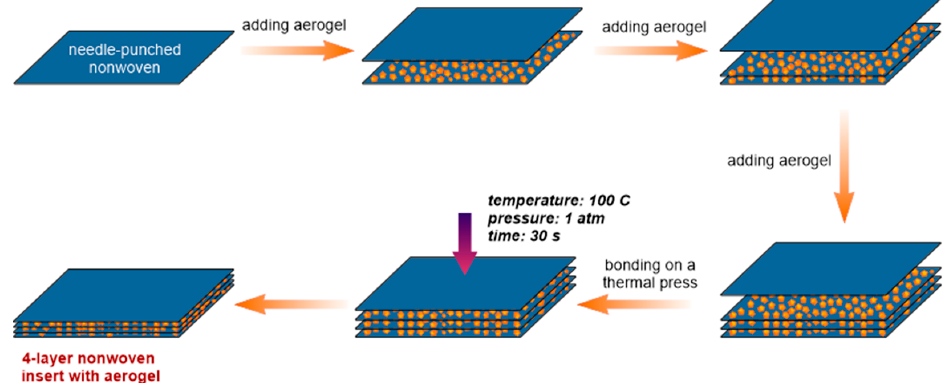
Figure 1. Manufacturing process of a multilayer nonwoven insert with silica aerogel granules. Table 3. Composition of the nonwoven inserts.